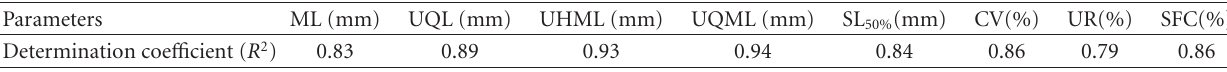
Table 2: Determination coe ffi cients between the parameters determined from the blends established models and the real ones. Parameters ML (mm) Determination coe ffi cient ( R 2